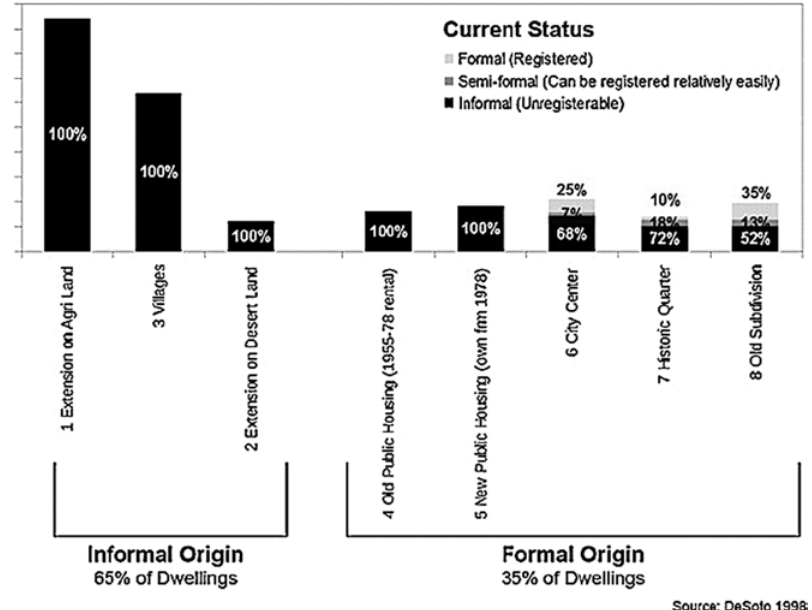
Figure 1. Typologies of informal tenure in Egypt according to